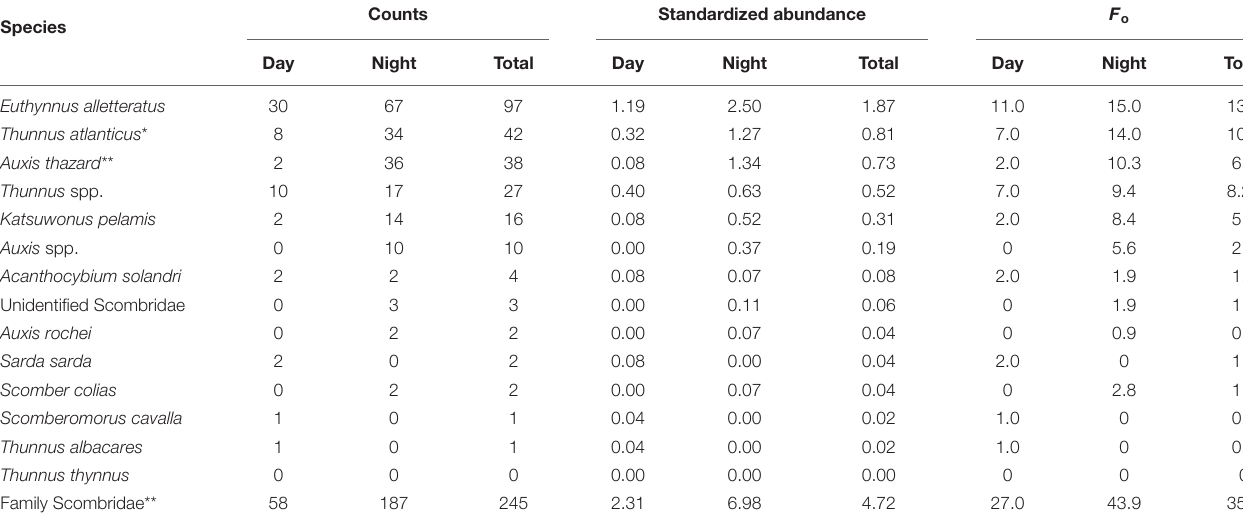
TABLE 2 | Total standardized abundance (no. ind. 10 − 5 m − 3 ) and F o (%) of scombrid larvae and juveniles collected in the epipelagic zone. Counts Standardized abundance Species